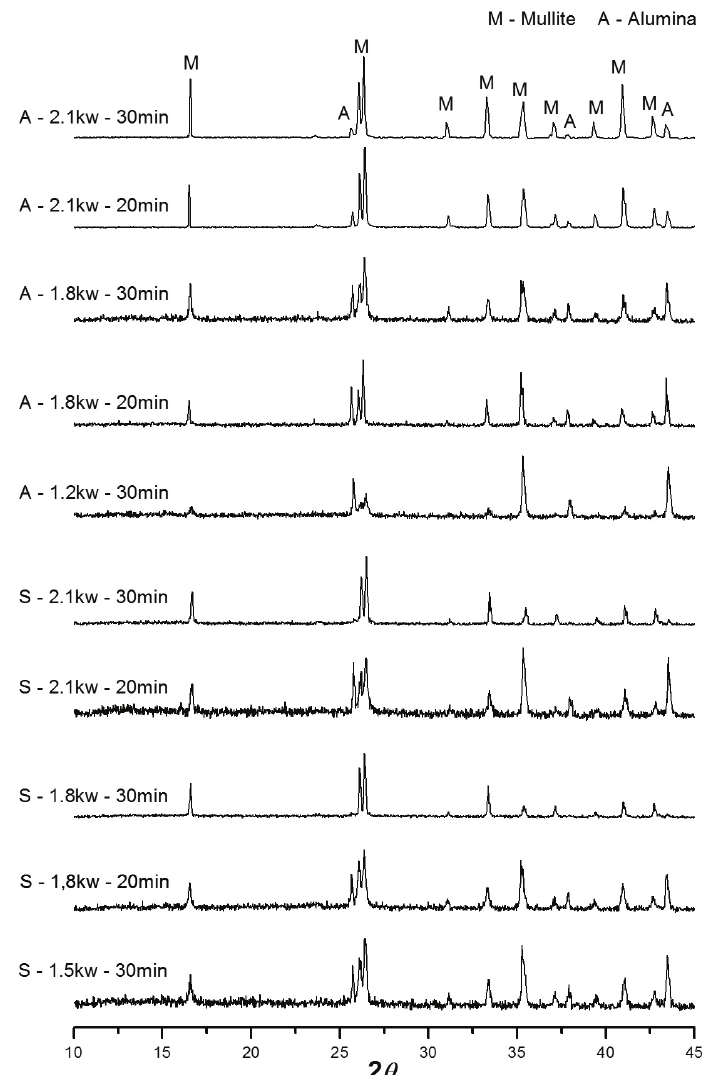
Figure 2. X-ray diffraction patterns of samples A and S sintered for 20 and 30 min at 1.2, 1.8 and 2.1